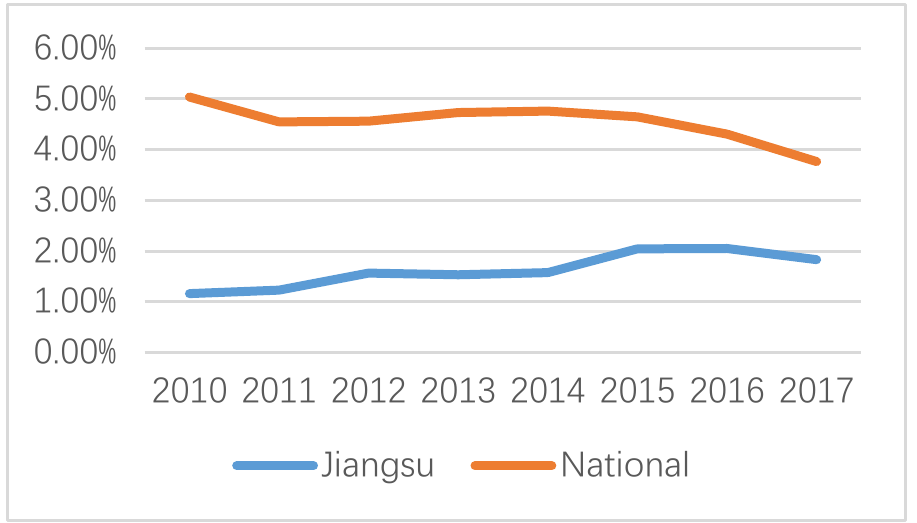
Figure 3 . Change in the share of energy industry investment in GDP, 2010 – 2017. Figure 3. Change in the share of energy industry investment in GDP,